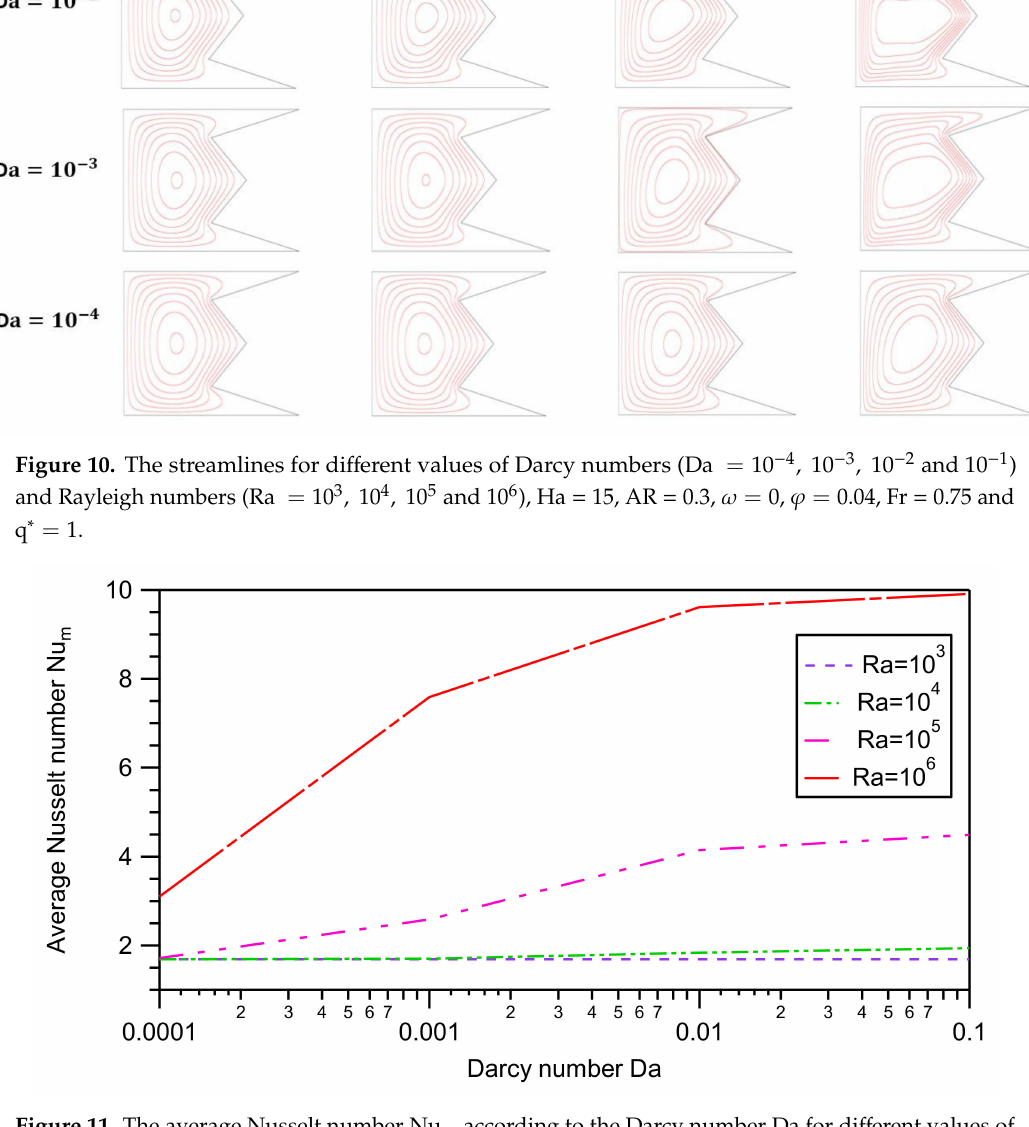
Figure 11. The average Nusselt number Nu m according to the Darcy number Da for di ff erent values of Rayleigh number (Ra = 10 3 , 10 4 , 10 5 and 10 6 ) with AR = 0.3, ω = 0, ϕ = 0.04, Fr = 0.75 and q ∗ =